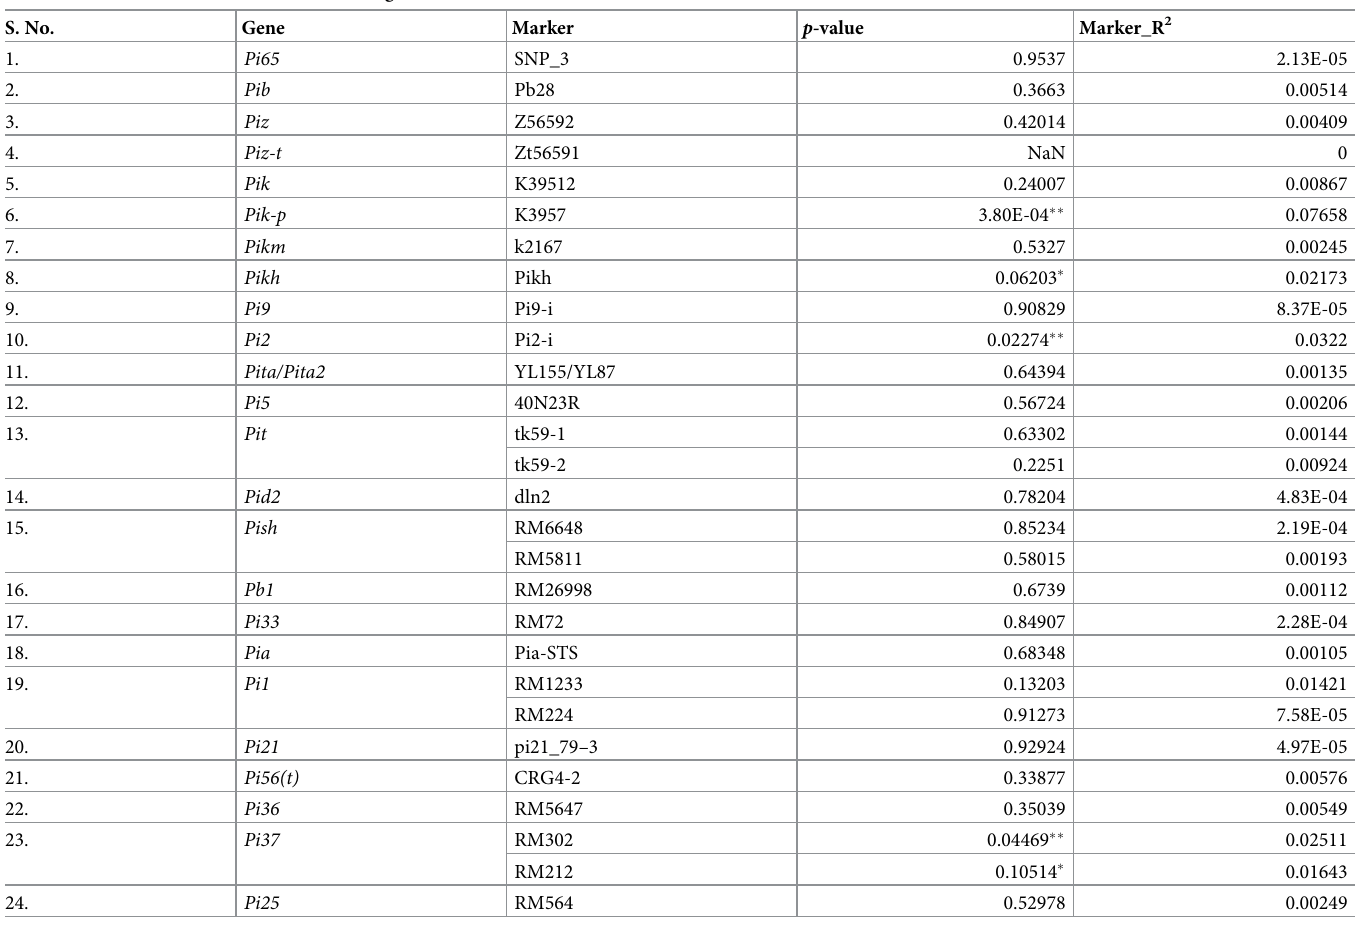
Table 4. Genetic association of blast resistant genes with rice blast disease in 161 landraces. S.